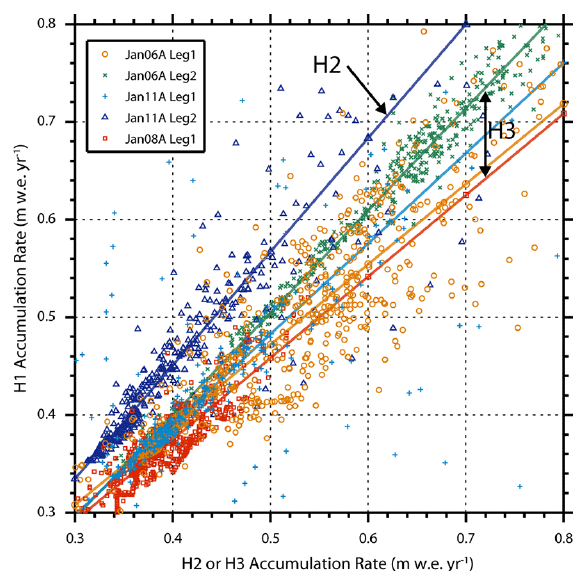
Figure 5. Bias correction regression models for five survey legs where an alternate horizon was used to measure accumulation. Us- ing a robust regression model, we correct accumulation measure- ments derived from the alternate horizon (either H2 or H3) to more appropriately represent its H1 measurement where both horizons were coincidently tracked. The relationship was then applied to the measurements derived from the alternate horizons where H1 was not tracked. Four of the corrections use the same alternate horizon H3, whereas one leg uses H2. Interestingly, H2 dates to 1939 and the resulting accumulation rates are found to be much lower than those from H1 (i.e., the regression model lies well above the 1:1 line). This result is consistent with ice-core observations that recent accu- mulation has increased relative to the long-term mean. Corrections for measurements derived from H3, dated to 2002, hover around the 1:1 line, especially in the areas of the majority of the measurements (0.3–0.5mw.e.yr − 1 )